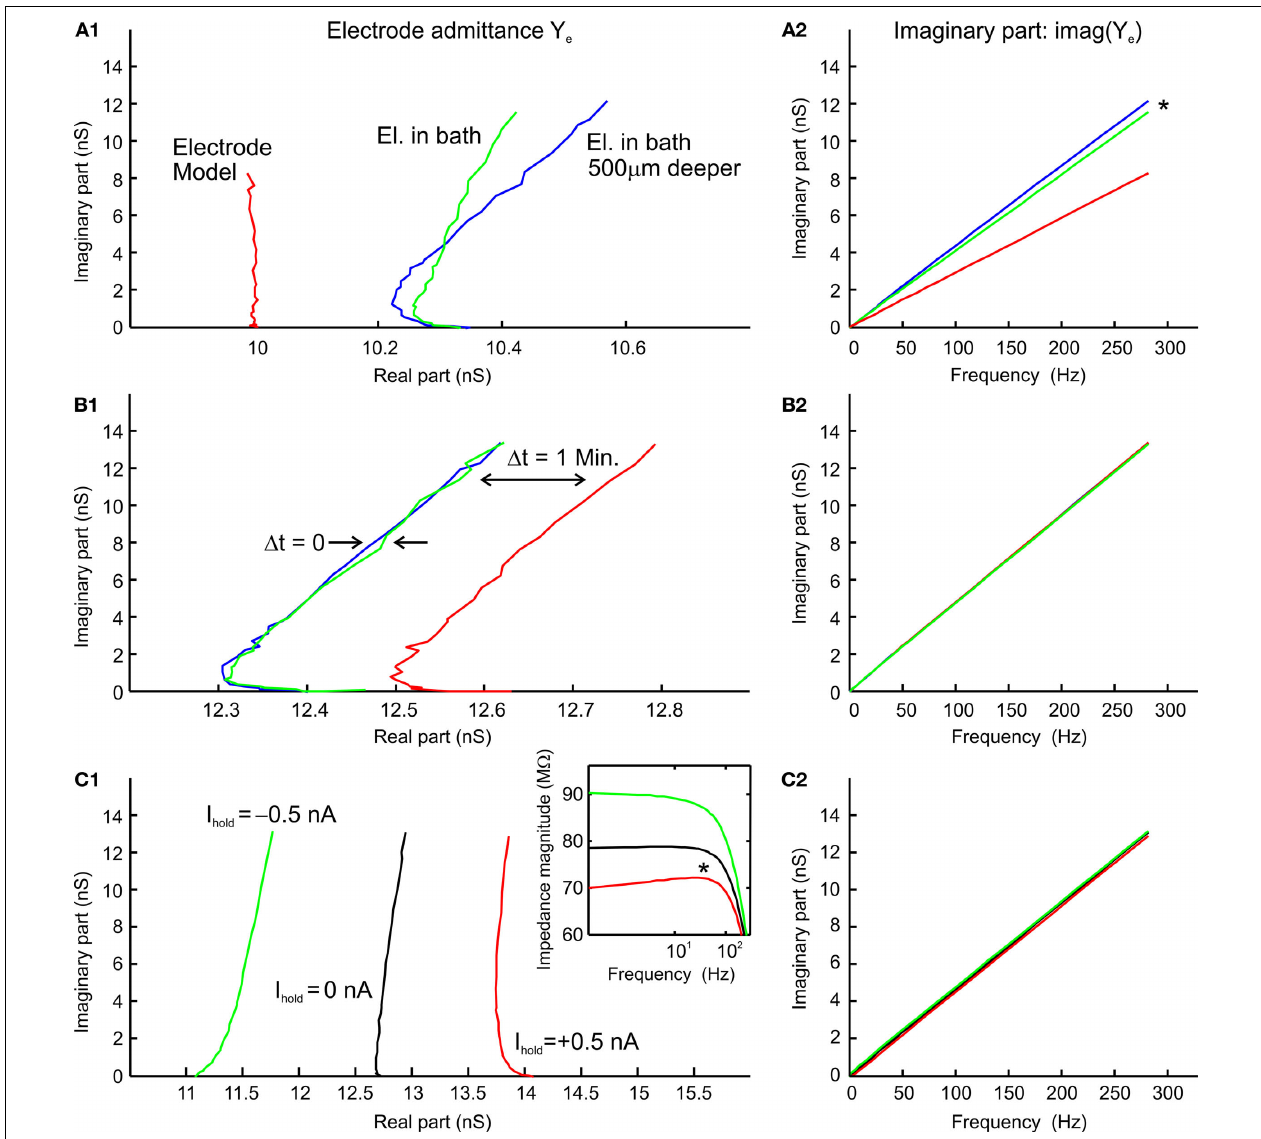
FIGURE 2 | Multi-sine analysis of electrode properties with discrete plots (B1) of three measurements of electrode properties in the recording frequencies plotted for the range from 0.2–300 Hz. (A1,A2) Admittance chamber; measurements 1 and 2 were consecutive (green and blue lines), plots (A1) of the electrode model circuit with constant parallel capacitance and whereas the measurement 3 (red line) was taken 1 min later; note that the resistance (red line); admittance plots (A1) of KCl (3 M) fi lled electrode with admittance fl uctuates over time while the capacitance (B2) remains stable; the tip at 1.5 mm (green line) and 2 mm below the surface of the Ringer I = 0 nA. (C1,C2) Admittance plots (C1) of three electrode measurements hold solution (blue line) show frequency-dependent changes of electrode properties with different holding currents I = 0 nA (black line), − 0.5 nA (green line), hold + 0.5 nA (red line); injection of a constant current changes the real part of the infl uenced by the depth in the Ringer solution; plots of the imaginary part (A2) show that the electrode capacitance increases with increasing electrode admittance response while the capacitance (C2) remains depth of the electrode tip in the bath (*); I = 0 nA. (B1,B2) Admittance hold